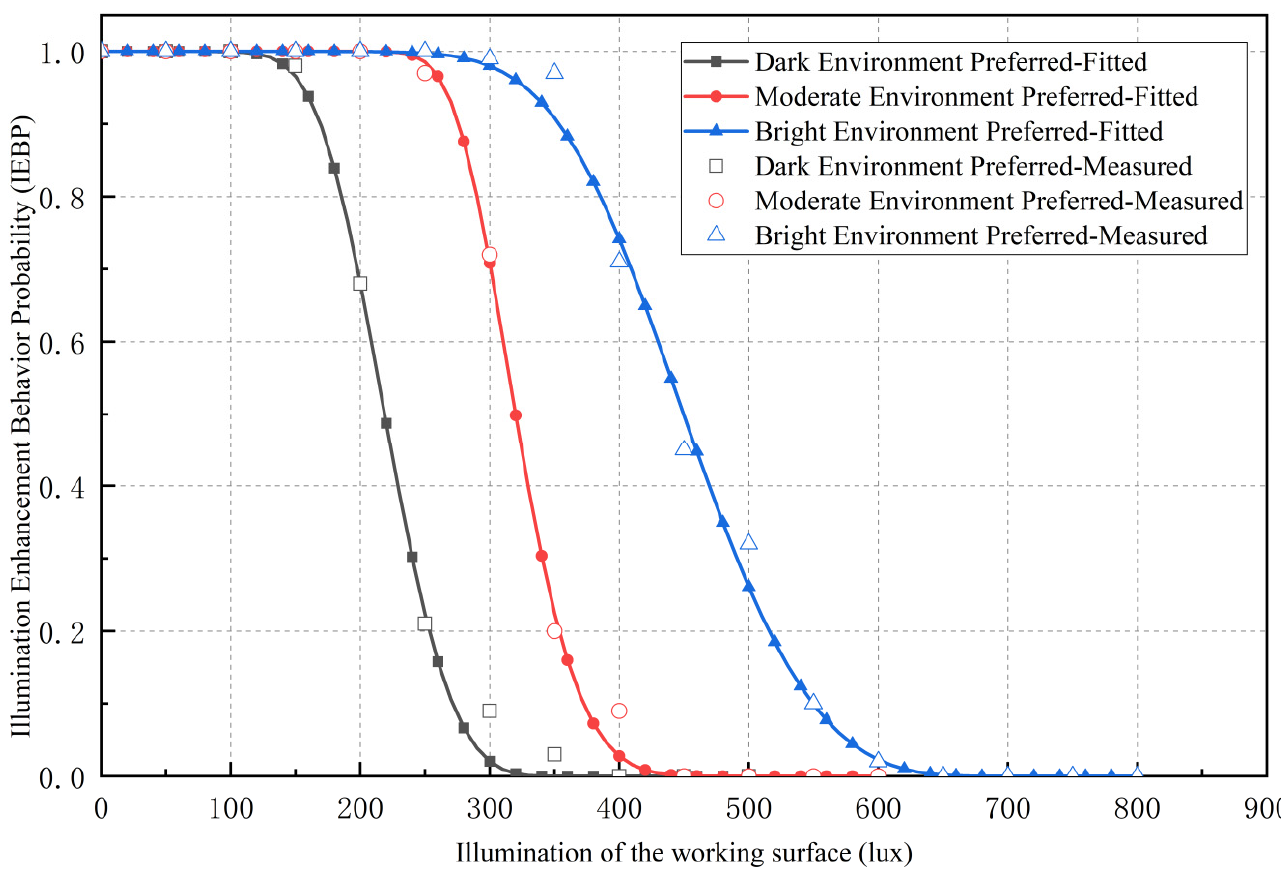
Figure 12. Probability of illumination enhancement behavior of different occupant types. Table 7. Probability fitting equation for illumination enhancement behavior of different occupant types.